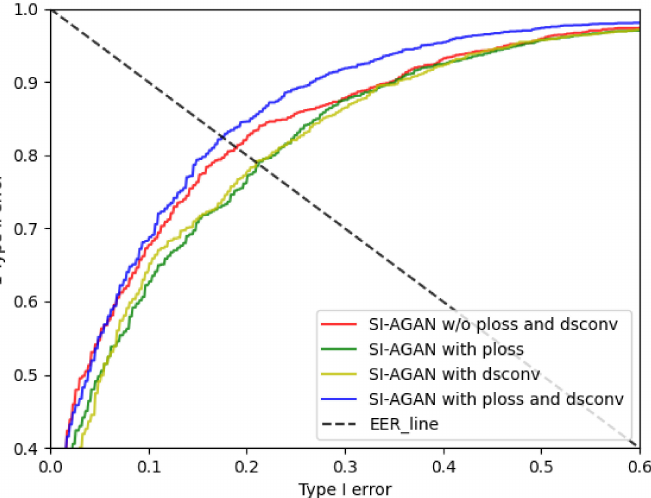
Figure 11. ROC curves of gender recognition accuracies of SI-AGAN with or without perceptual loss and depthwise separable convolution. (w/o refers to without, ploss refers to perceptual loss, dsconv refers to depthwise separable